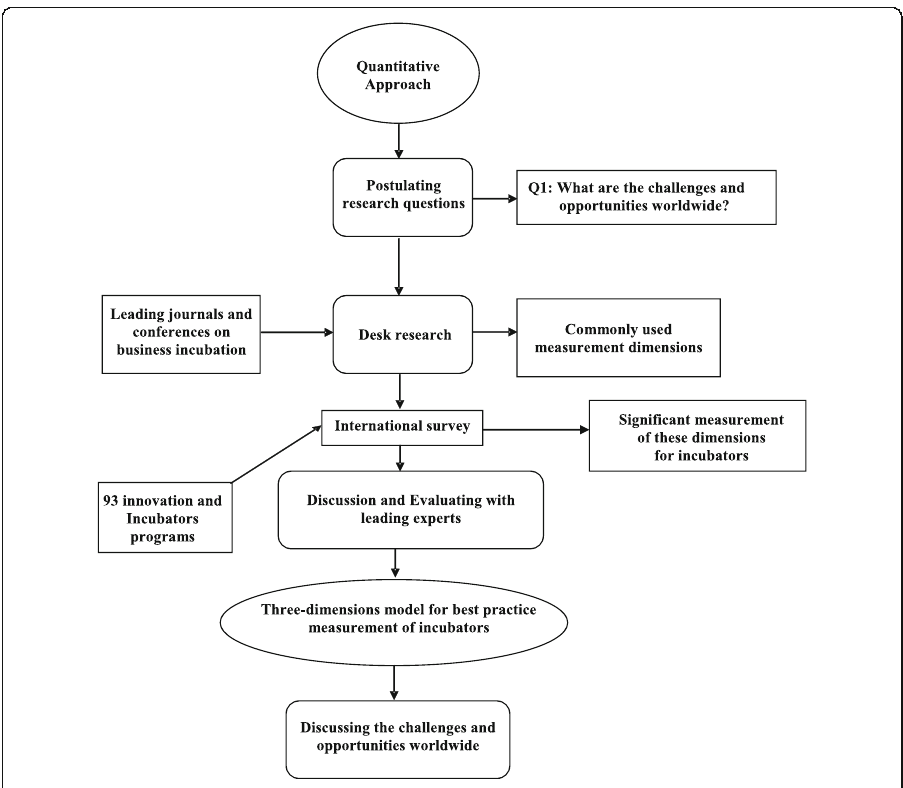
Fig. 1 The process of developing a research